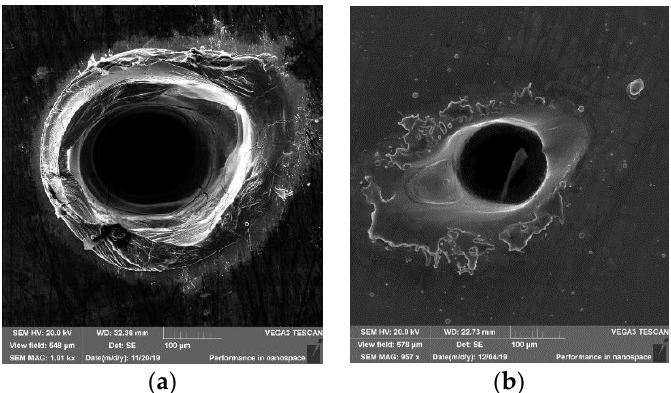
Figure 6. Craters obtained in ( a ) the bulk sample and in ( b ) the layer after maximal focusing of the laser beam.